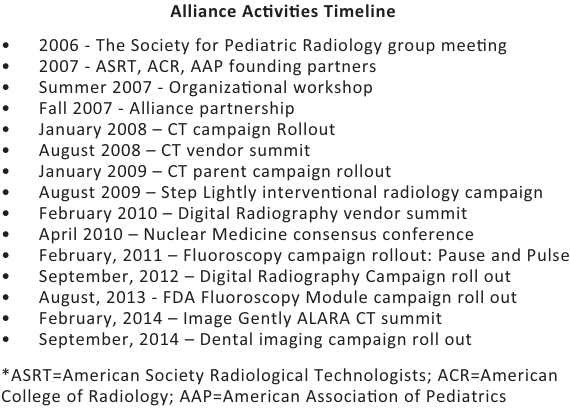
Alliance Ac(cid:23)vi(cid:23)es